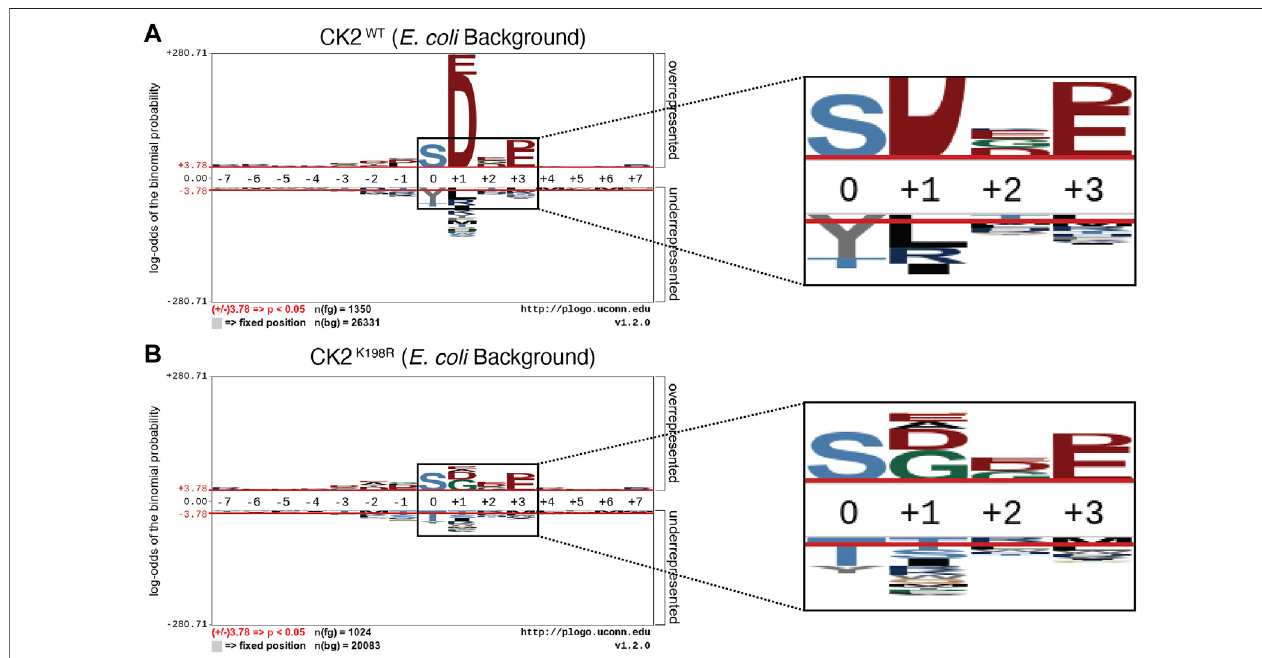
FIGURE 1| CK2 K198R mutation shifts overall speci fi city motif . Substrate speci fi city ofCK2 WT (A) and CK2 K198R (B) . The CK2 K198R mutation results in a decreased preferenceforacidic(D/E)residuesinthe+1positionaswellasareorderingofphosphoacceptorpreference.InCK2 K198R ,adecreasedpreferenceforthreonineispaired with an increase in preference for